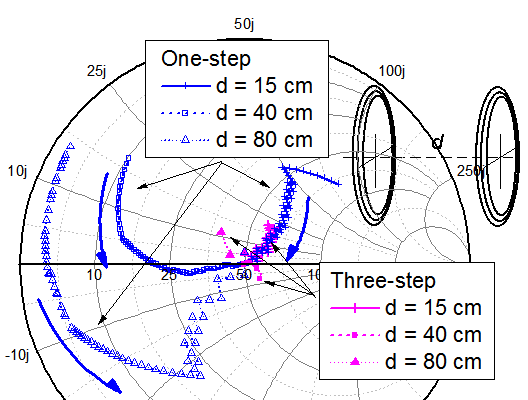
Figure 11. Measured trajectories of the input impedance for three